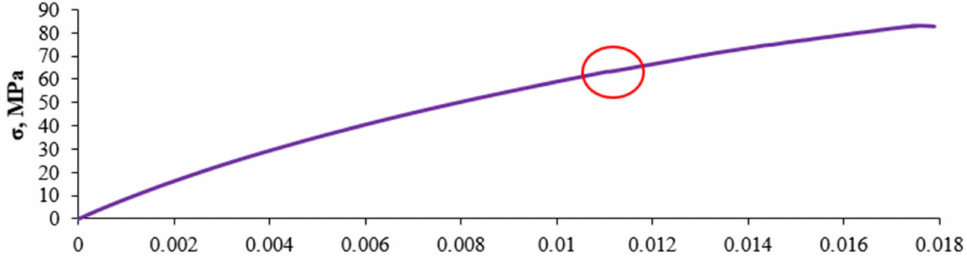
Figure 5. An example graph of a static test on stretching the composite with a 10% recyclate content.